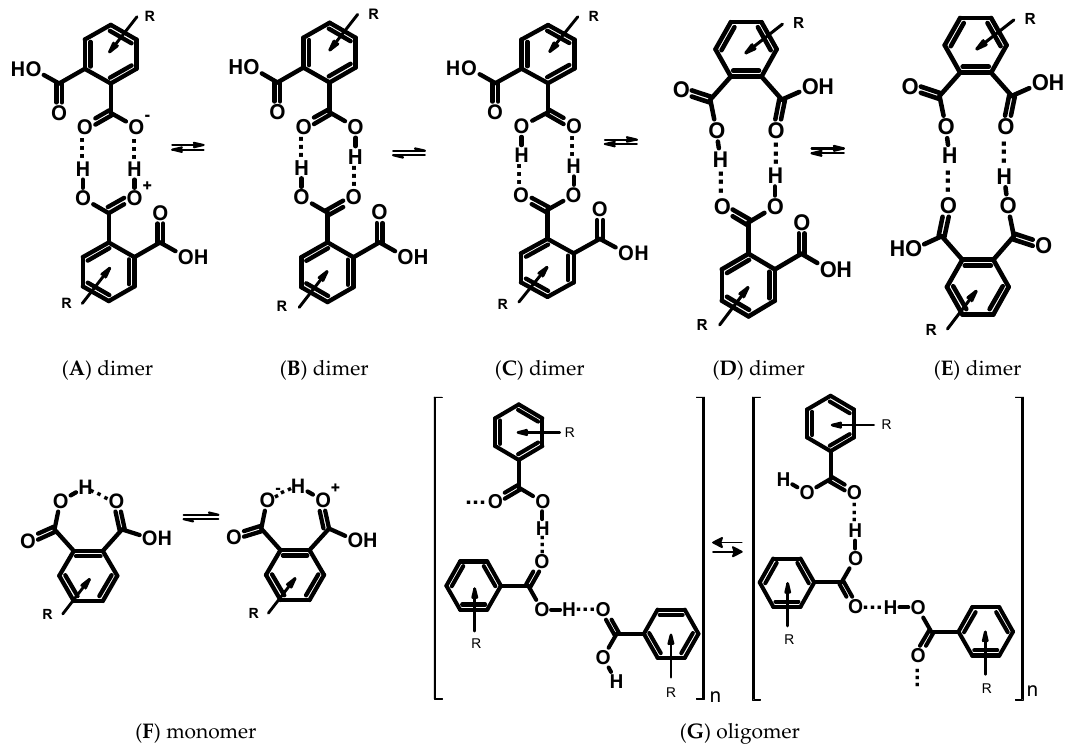
Figure 5. Schemes of the prototropic equilibria for the carboxyl aryl derivatives and their intermolecular complexes.